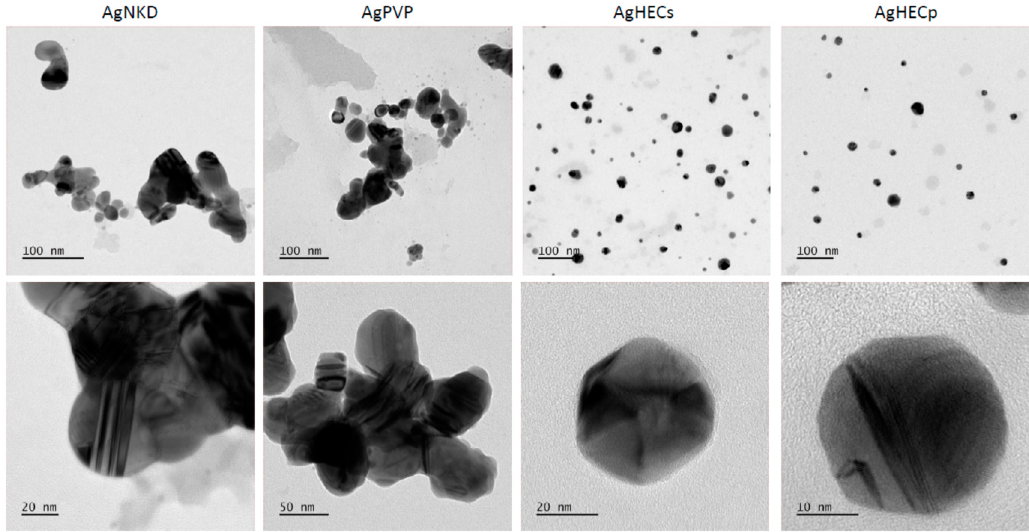
Figure 3. Transmission electron microscopy images of Ag NP suspensions. Ag NPs in MilliQ water were analyzed by TEM. The images in the upper panel show how particle suspensions are dispersed and in the lower panel is shown a detail of small agglomerates or single particles.